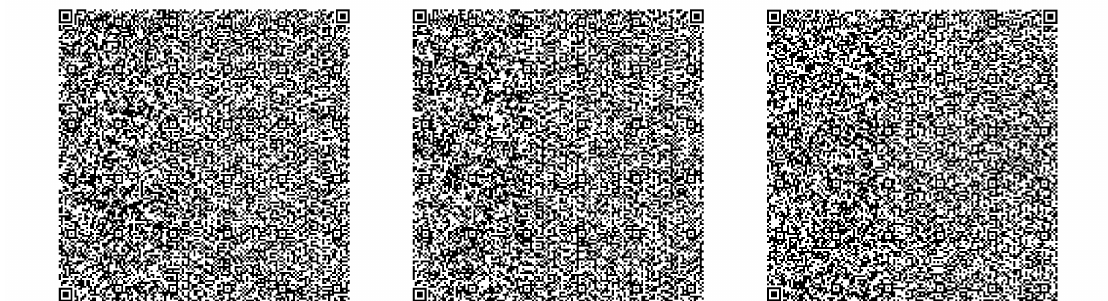
Figure A4. QR codes with the positions ( x , y ) and excitations ( a ) of the radiators for the 370 elements sparse layout.